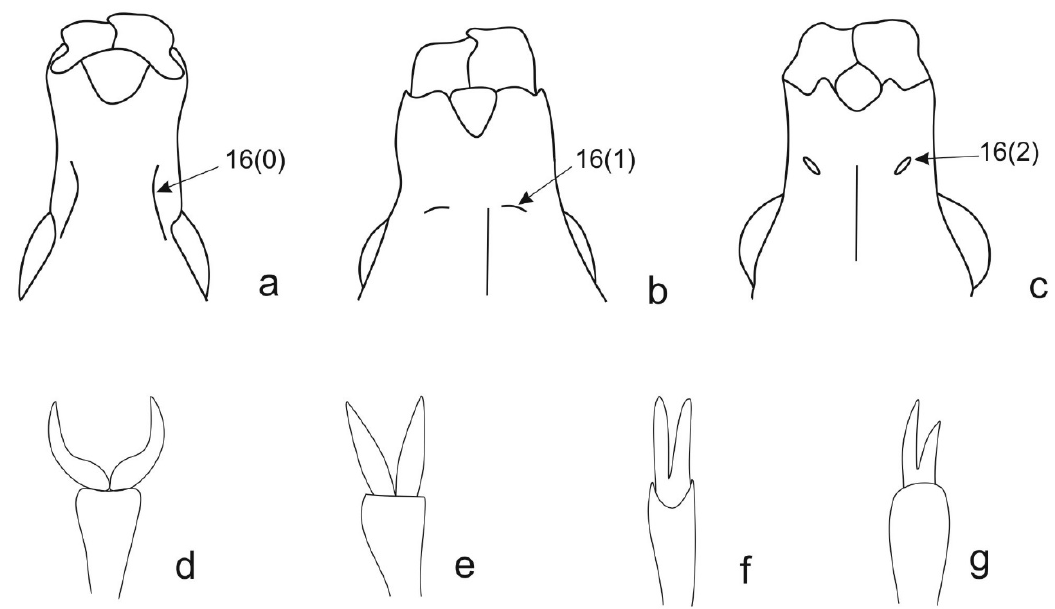
Figure 4. Morphology of adults, occipital sutures and tarsal claws. Head and rostrum, ventral view, position of occipital sutures (character 16): ( a ) longitudinal (16.0); ( b ) transversal (16.1); ( c ) reduced to a fovea (16.2). Tarsal claws (character 53): ( d ) free, widely separated (53.0); ( e ) free, moderately separated (53.1); ( f ) connate, claws of equal length (53.2); and ( g ) connate, claws of different length (53.2).